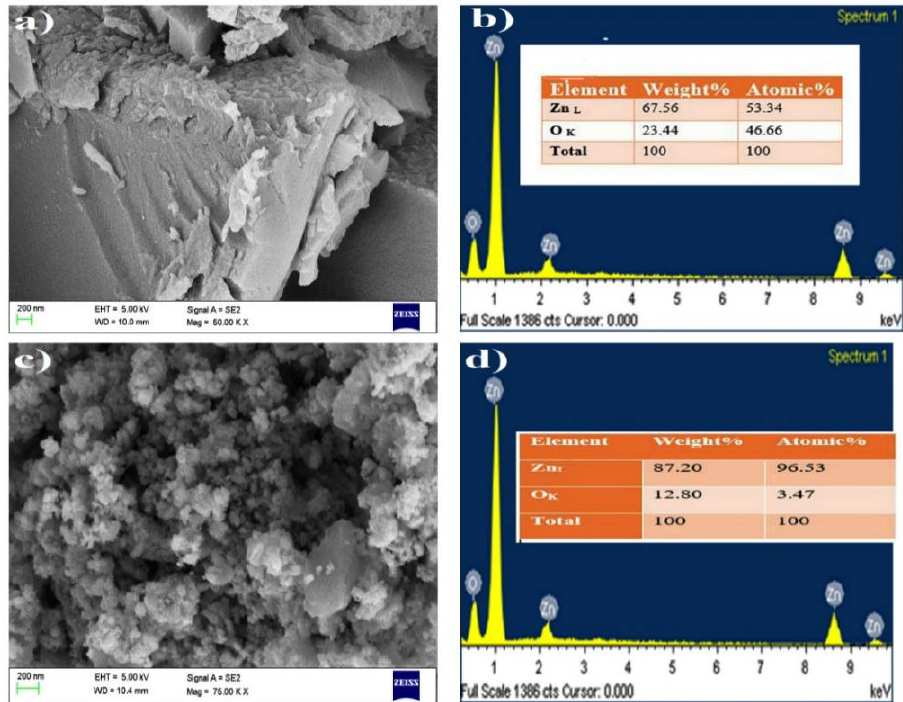
Figure 5. ( a , b ) SEM-EDS spectra of ZnO nanoparticles and ( c , d ) SEM-EDS spectra of H-ZnO nanoparticles